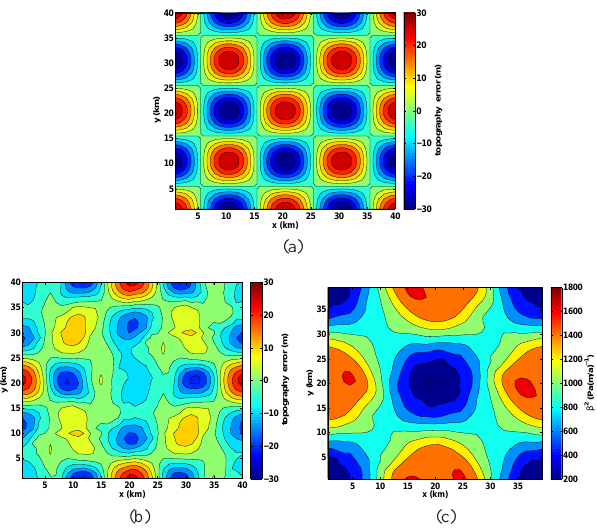
Fig. 9. (a) The error inherent in the initial guess for bed topography, weakly-constrained surface elevation. (b) The error in bed topography at the end of the inversion. Note that error is reduced where surface velocities are high or true bed topography is relatively flat. (c) Corresponding inversion for β 2 .